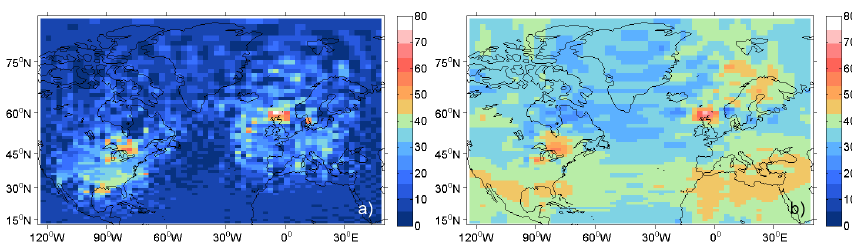
Figure 9. Reconstruction with (a) spherical harmonics and (b) discrete Meyer at high resolution with Gaussian noise added to the observa- tions. The Gaussian noise has zero mean and a standard deviation of 1TEC unit.